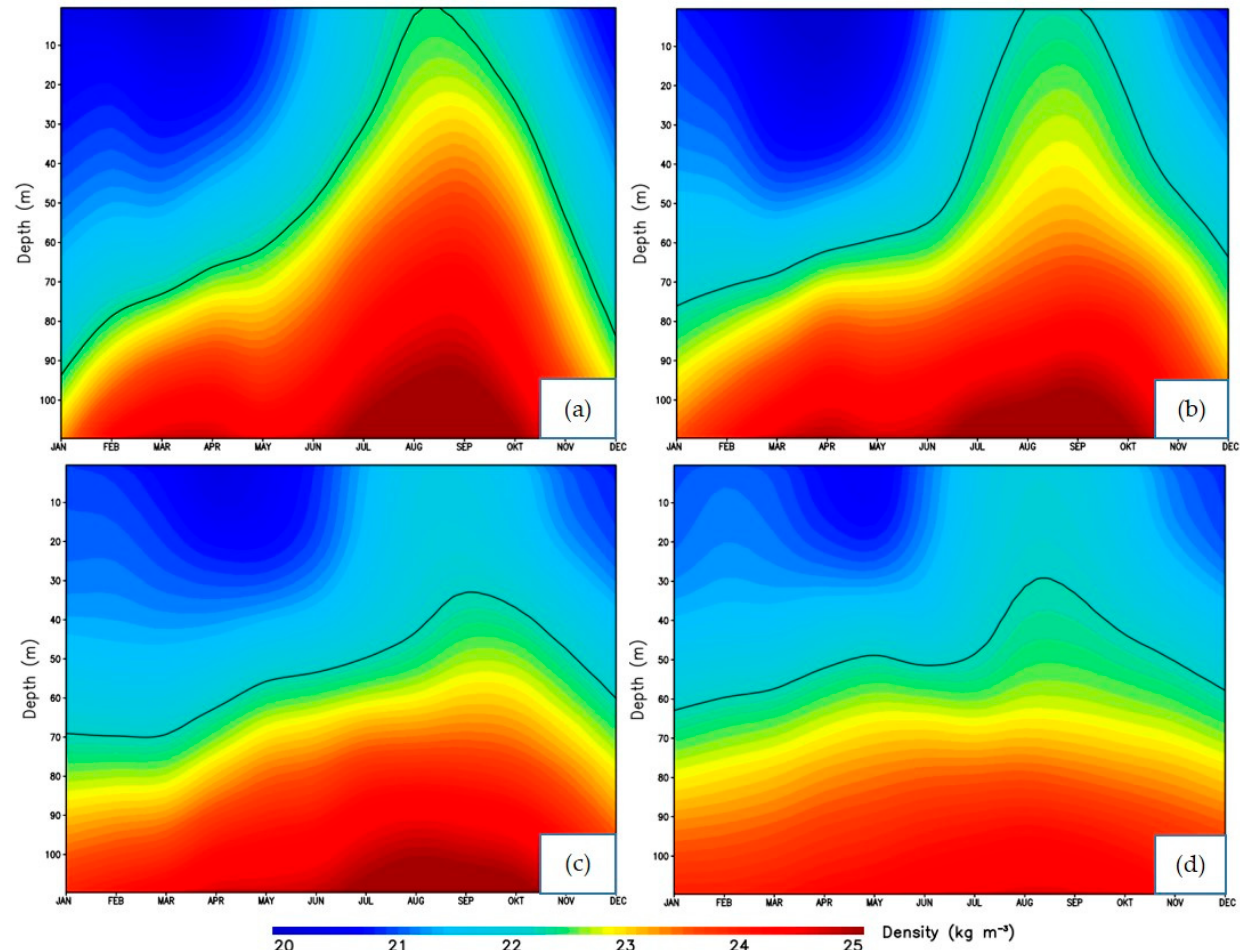
Figure 11. The climatological monthly mean values of the sea water density in the vertical profile in ( a ) Box 1, ( b ) Box 2, ( c ) Box 3, and ( d ) Box 4, respectively. The black contours are isopycnals of 22.2 kg m − 3 .